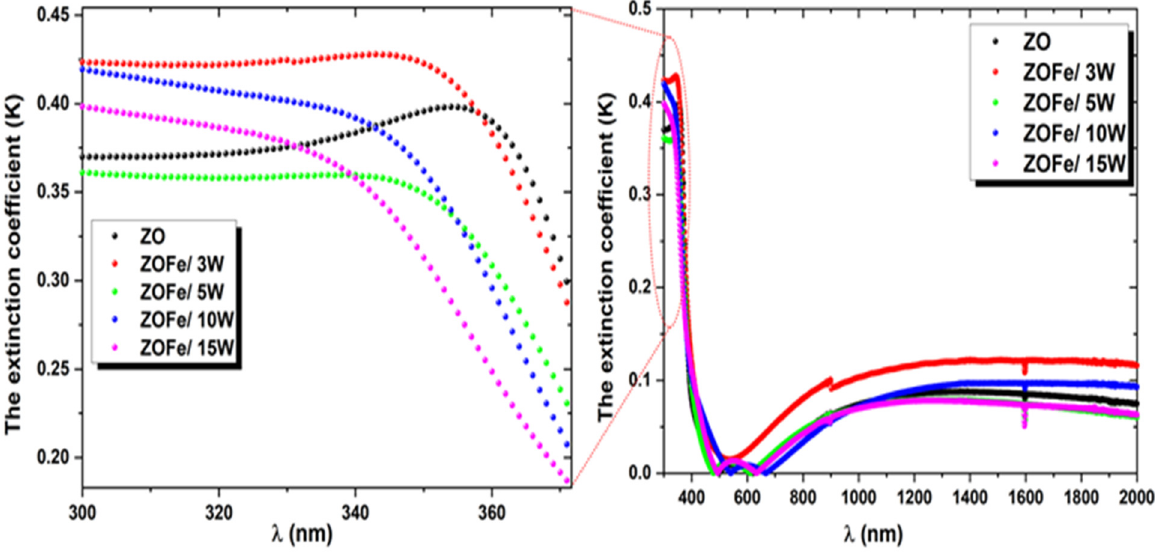
Figure 14. The extinction coefficient (K) as a function of the wavelength ( λ ) for the undoped and Fe doped ZO films.